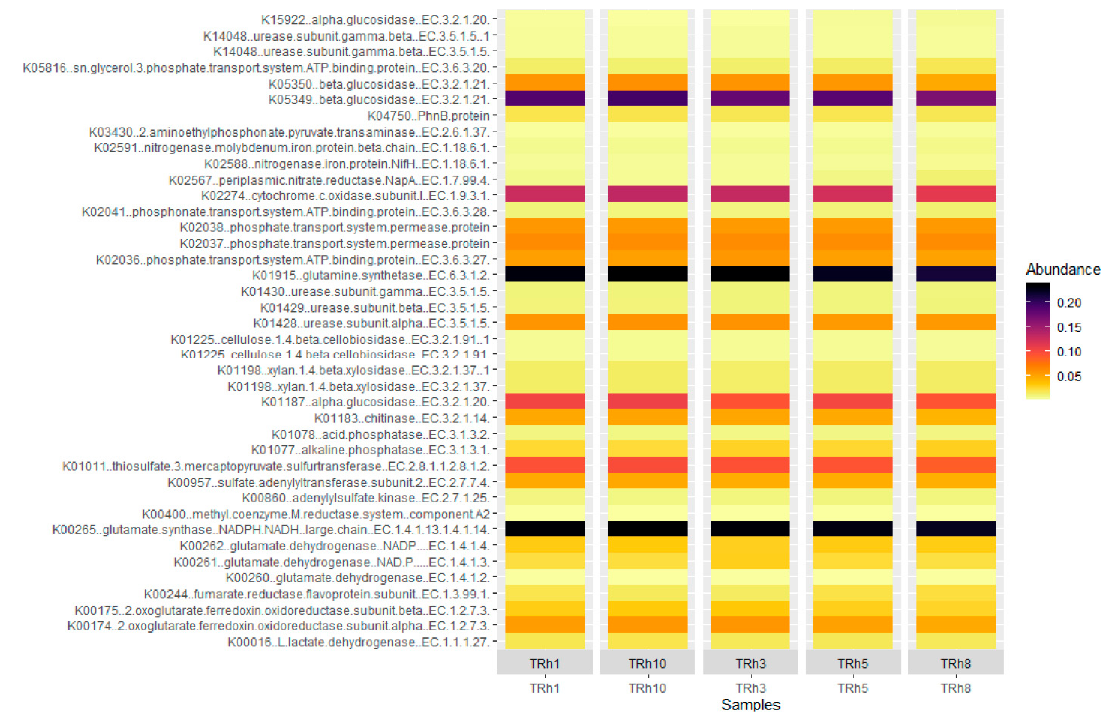
Figure A2. Heatmap shows functions of bacteria predicted by Tax4Fun. The data based on OTUs abundance derived from rhizosphere soil samples (TRh) of red clover ( Trifolium pratense